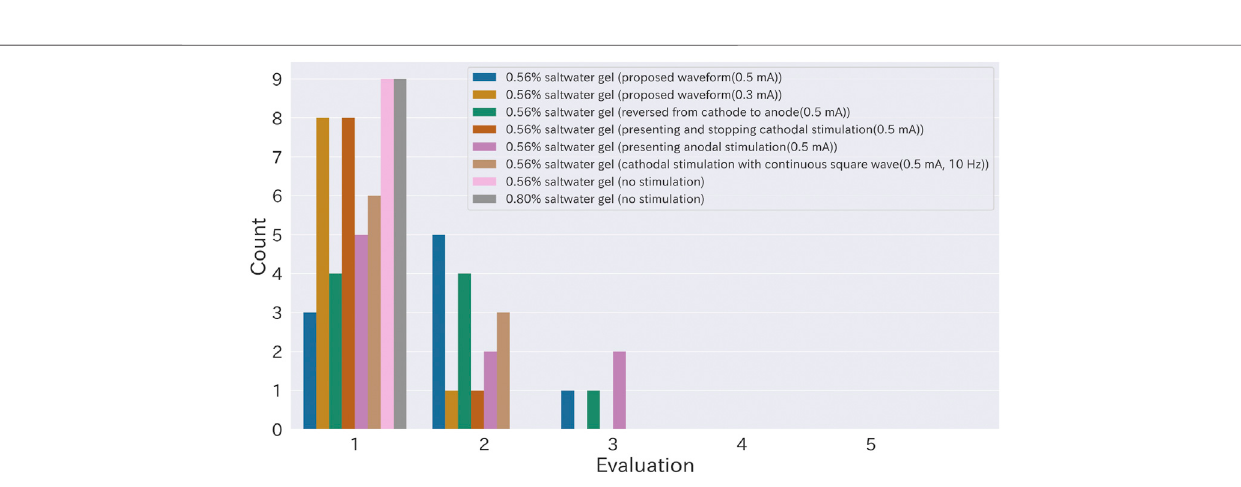
Frontiers in Virtual Reality |